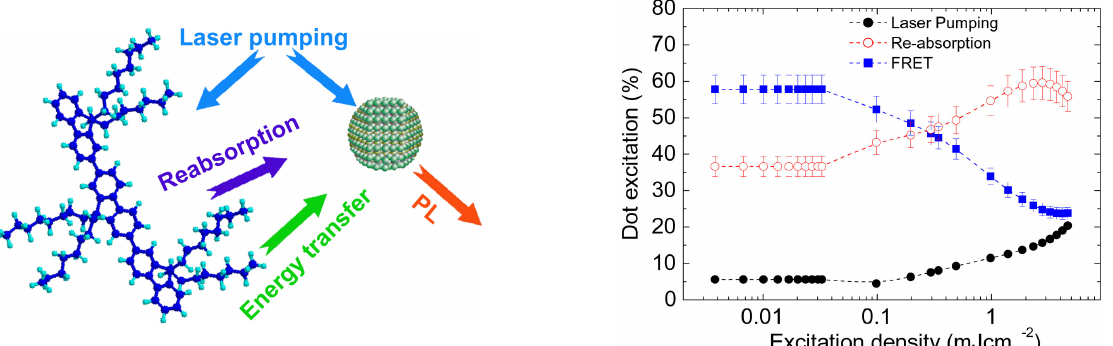
Figure 5. ( left ) Pictorial view of the PF8 and NCs excitation processes leading to NC PL emission. ( right ) Relative weight of the NCs pumping processes as a function of the excitation density. Reprinted with permission from [41]. American Chemical Society,